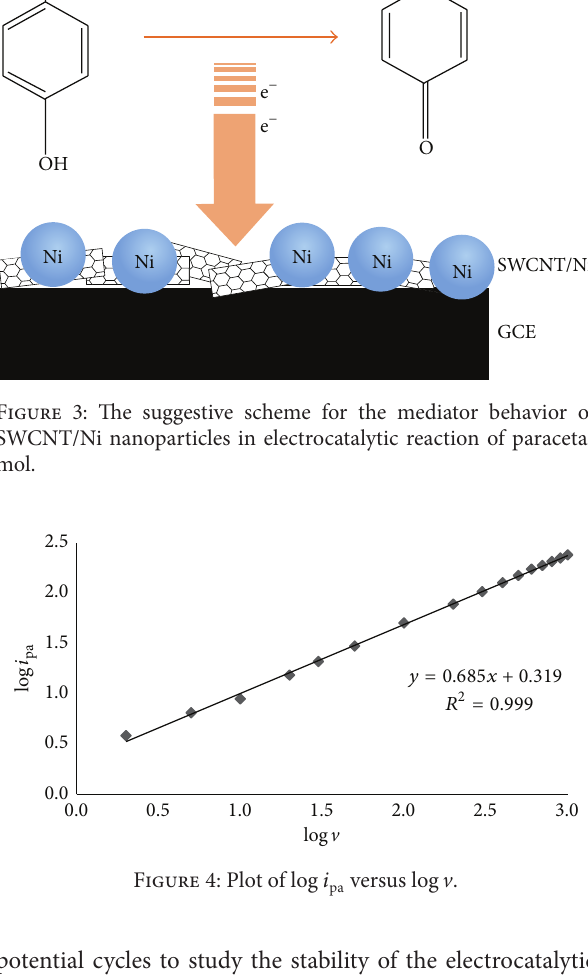
versus log V pa